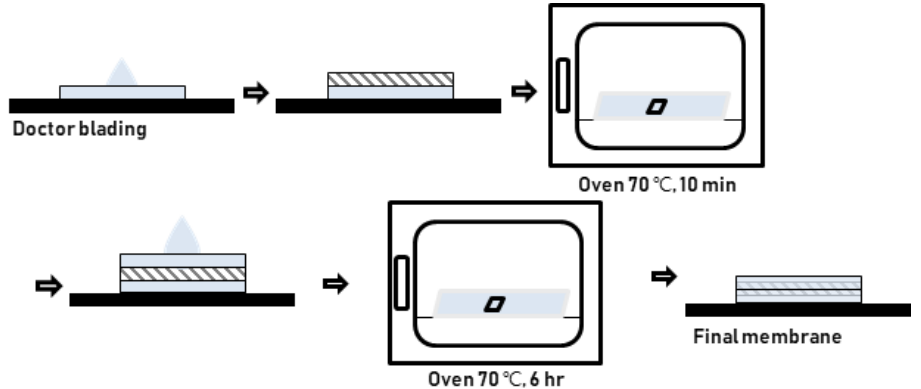
Figure 2. Schematic diagram of the preparation of porous PTFE-reinforced composite membranes.